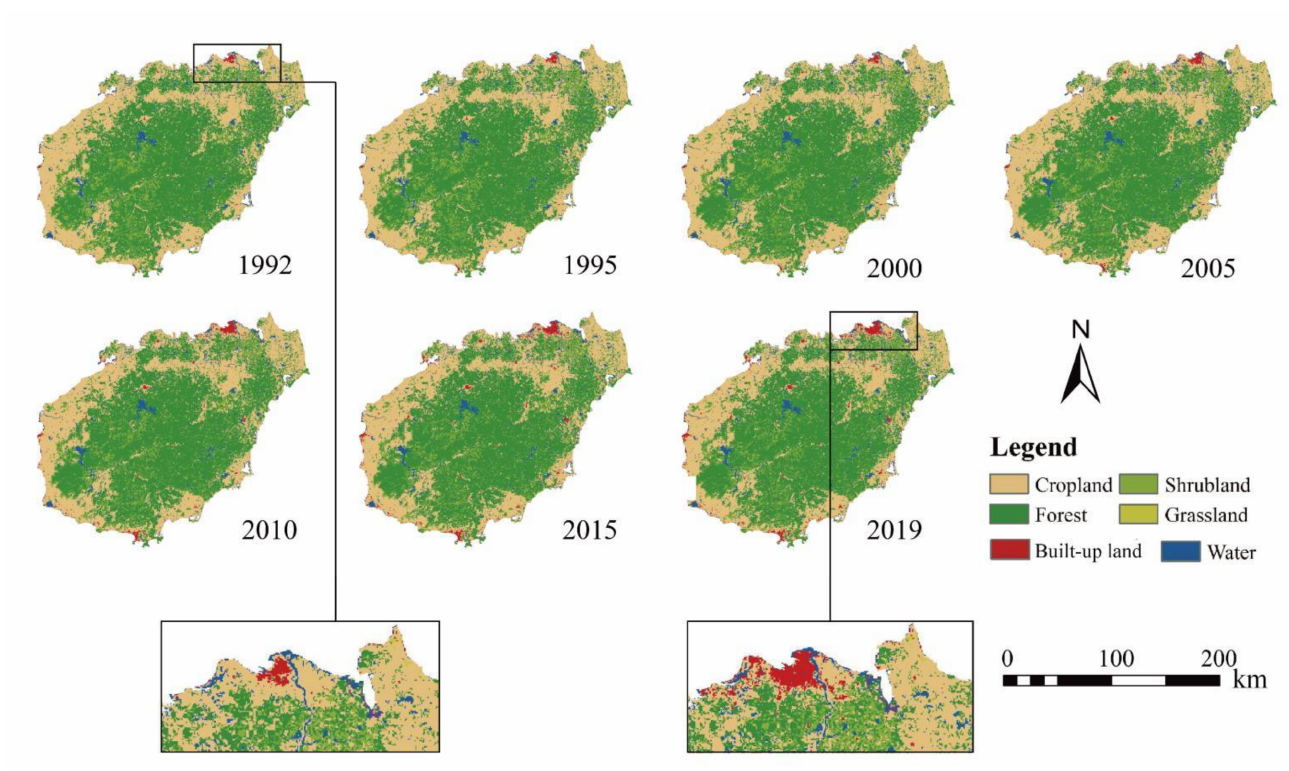
Figure 5. LULC distribution dynamics of Hainan Island from 1992 to 2019. Table 3. Proportion of transfers between LULC types, 1992–2019.